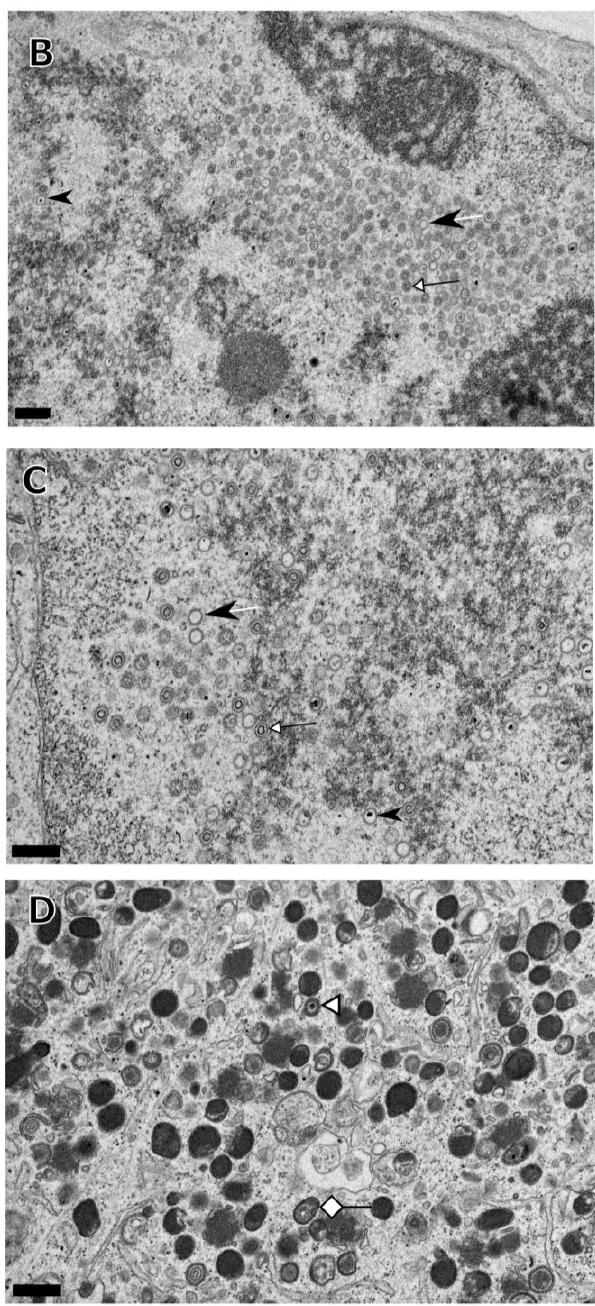
Figure 4. Transmission electron micrograph of HF cells infected with HCMV (Towne) and incubated in the presence of BDCRB for 4 days, the drug was then washed out and cells were incubated further for 3 days in the absence of BDCRB before processing. ( A ) A single infected cell showing nuclear inclusion (NI) as well as cytoplasmic inclusion (CI); ( B ) A part of the nucleus demonstrating mostly B-capsids on the right half of the image and a mix of A-, B- and C-capsids on the left half of the image; ( C ) A higher magnification image of the part of the nucleus containing a mixed population of capsids; ( D ) A part of the cytoplasmic inclusion (CI) showing enveloped virus particles. Scale: 4 µm ( A ), 0.5 µm ( B , C , D ). A- (white tailed arrows), B- (black tailed arrows), C-capsids (arrowheads), enveloped C-capsids (triangular arrowhead) and enveloped B-capsids